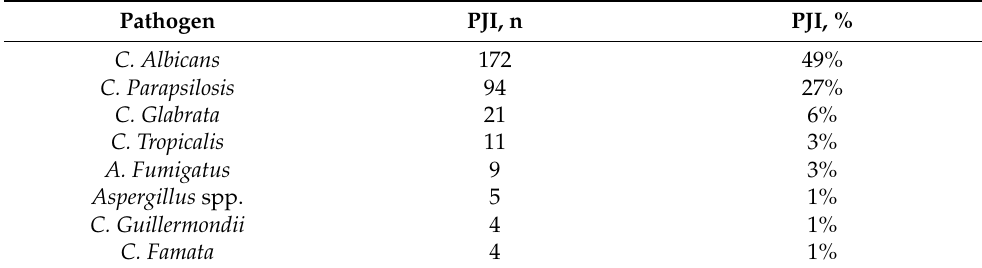
Table 2. Most frequently reported